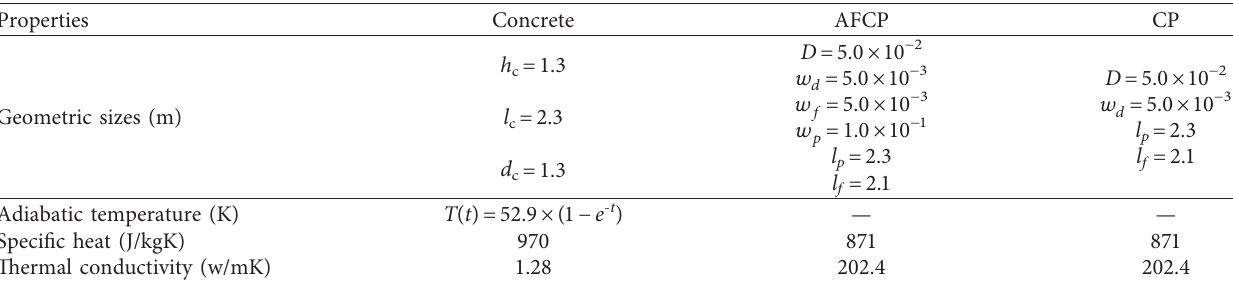
Figure 6: Mesh dividing of massive concrete: (a) 3D meshing; (b) water inflation setting; (c) meshing of the annular finned cooling pipe. Table 3: Design geometric and thermal parameters of the concrete and pipe.